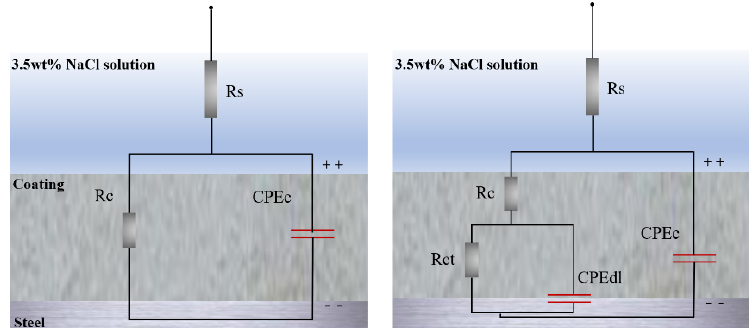
Figure 6. Equivalent circuits for modeling experimental impedance data.